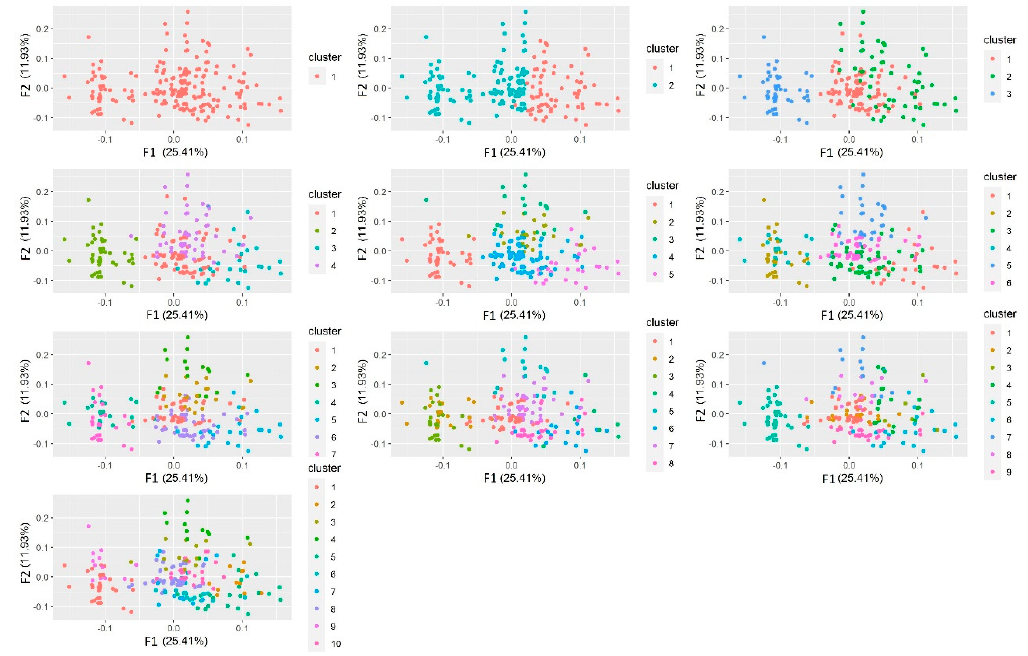
Figure 4. Scatter plot of the distribution of 221 pomegranate genotypes based on the first two factors from k = 1 to k =